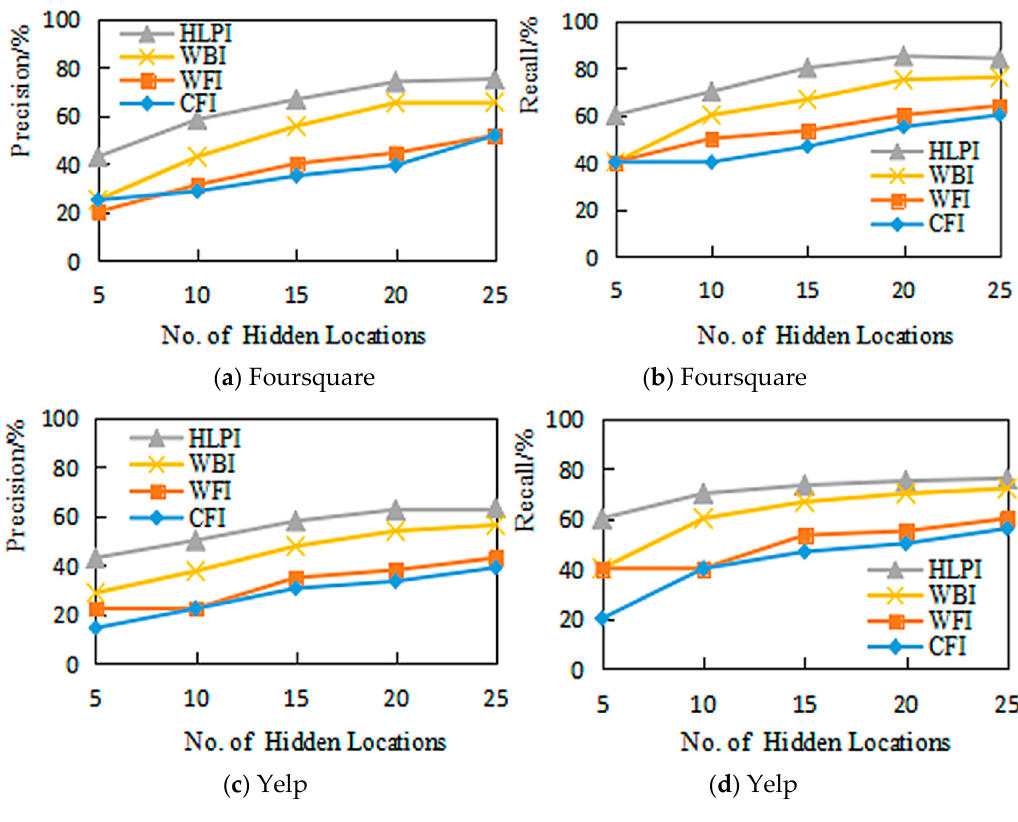
Figure 2. Prediction accuracy of four models.